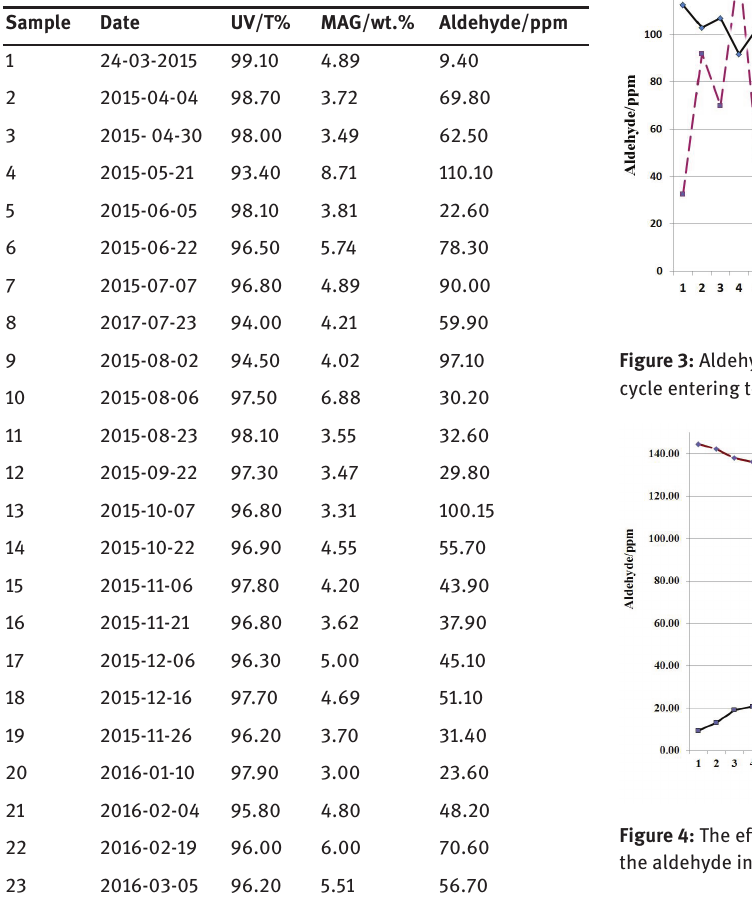
Table 2: Input aldehyde and the amount of UV light passing out of the reactor.